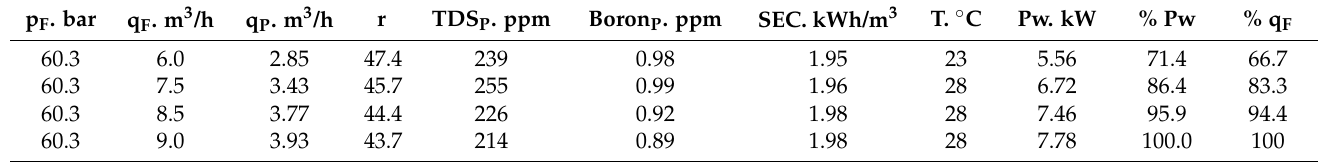
Table 2. Working conditions of a single pressure vessel combining two membrane models (1 LG SW 440 SR and 6 LG SW 440 GR) operated at a constant pressure under Mediterranean conditions at an unfavorable temperature.